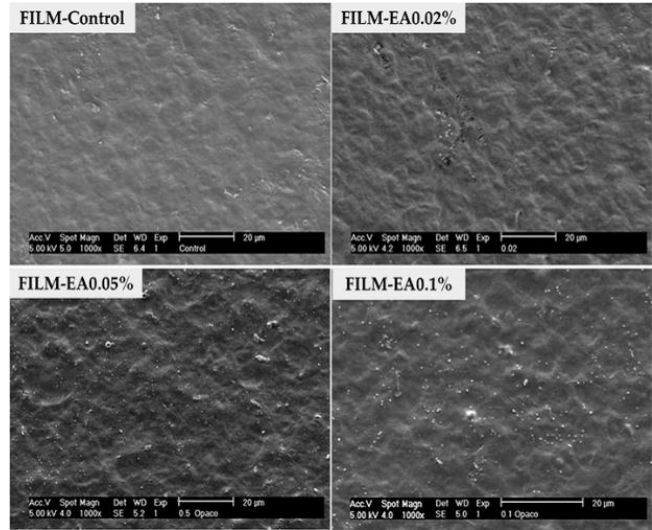
Figure 1. Surface morphology of apple starch films without ellagic acid (FILM-Control) and with ellagic acid (EA) added to 0.02% (FILM-EA0.02%), 0.05% (FILM-EA0.05%) and 0.1%